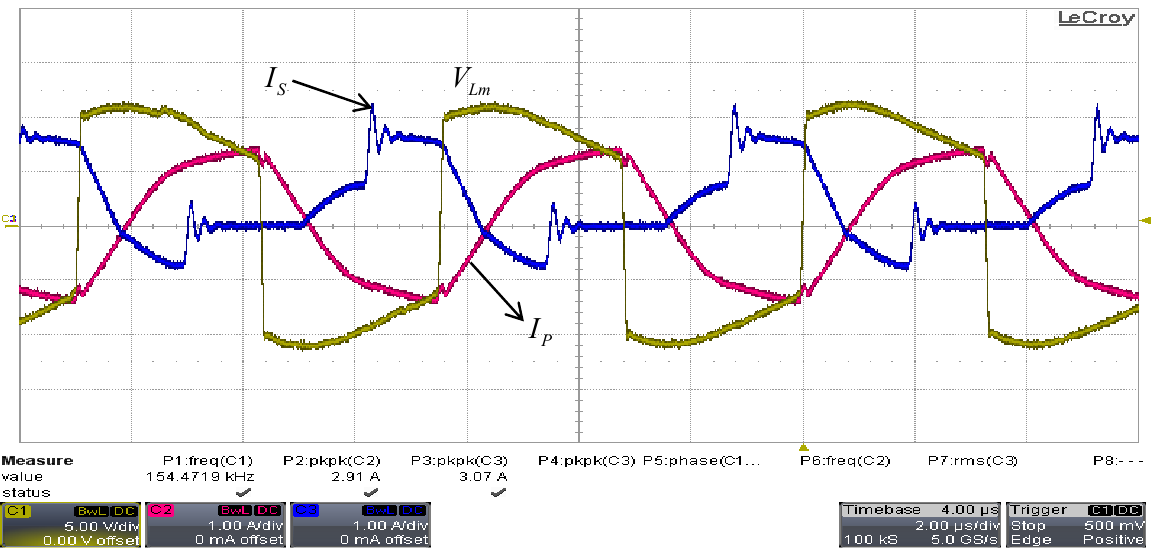
Figure 21. Test waveforms of LLC converter under the full load condition.